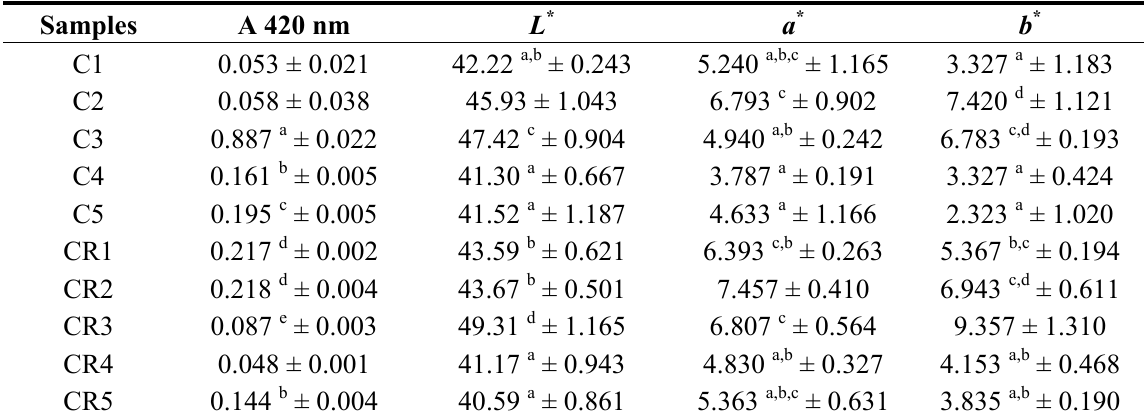
Table 2. The absorbance at 420 nm and the tristimulus L *, a * and b * values of cocoa beans.